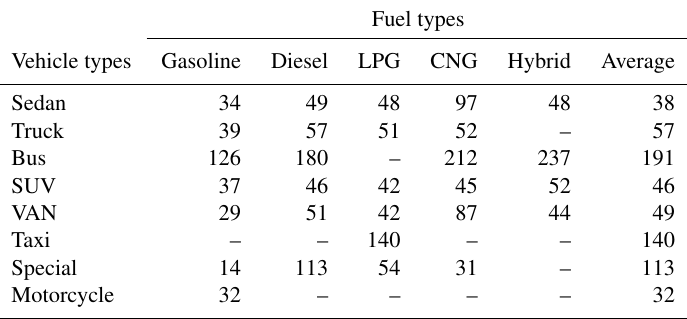
Table D1. The daily average VKT (kmd − 1 ) per vehicle by vehicle and fuel type.